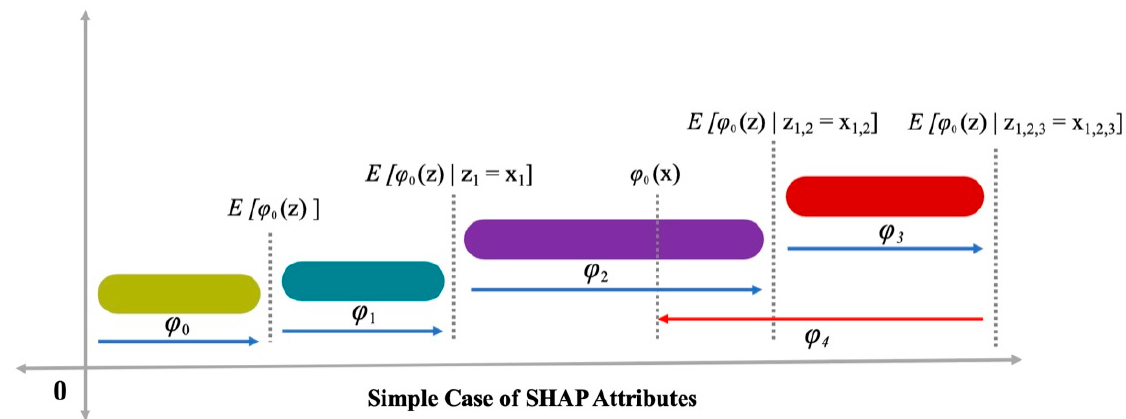
Figure 6. Attributes of SHAP